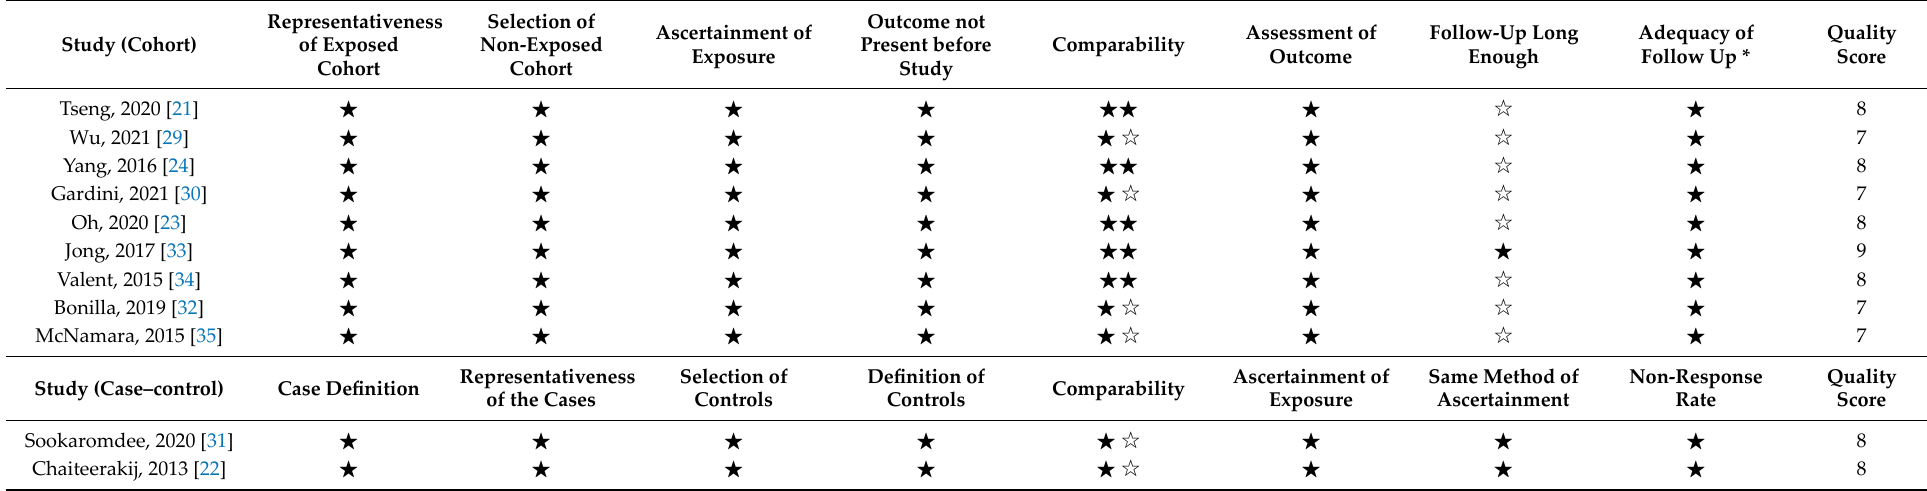
Table 2. The quality assessment of included